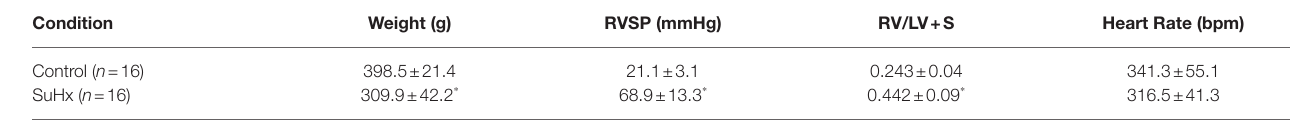
TABLE 2 | Hemodynamic and physiological measurements in Control and SuHx rats.